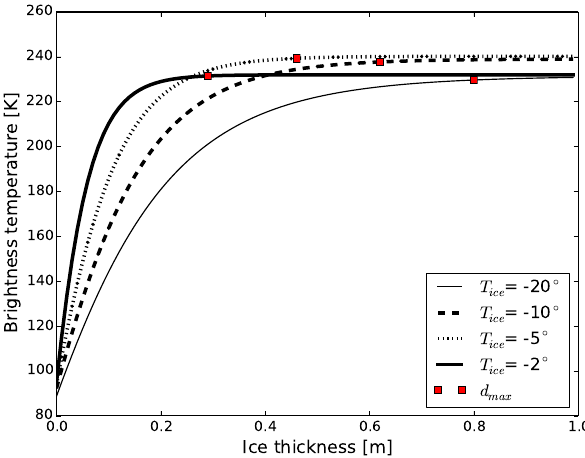
Figure 5. TB as function of d ice under different T ice , calculated